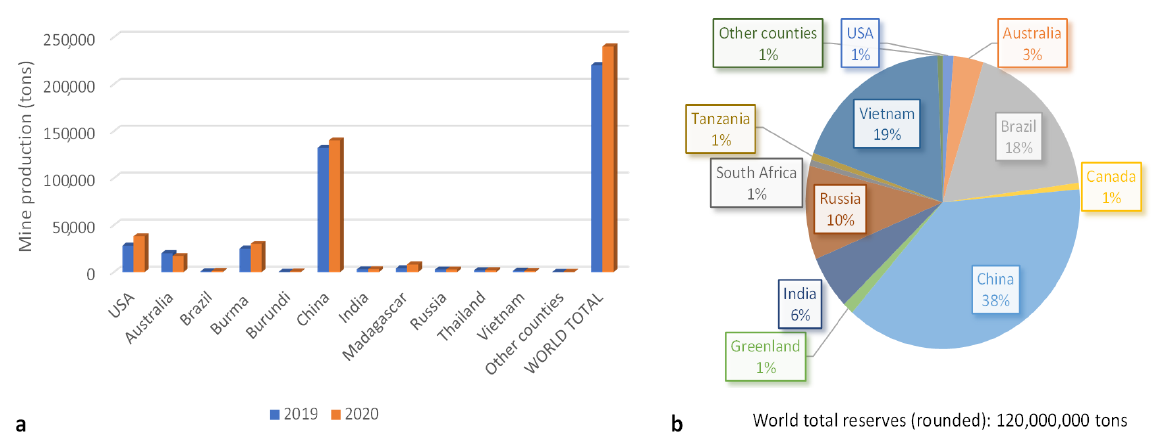
Figure 1. World mine production ( a ) and reserves ( b ) [18]. The falling trend in the price of rare earth products that began after prices spiked in 2011 was reversed. Prices for most REEs are rising compared with those in 2016 (Figure 2). The price of gadolinium, praseodymium, and neodymium experienced the greatest increase, whereas the yttrium and dysprosium prices declined. The estimated unit value of rare-earth compounds was USD 11.60 per kg in 2017, based on information from the U.S. Census Bureau on imports [20].